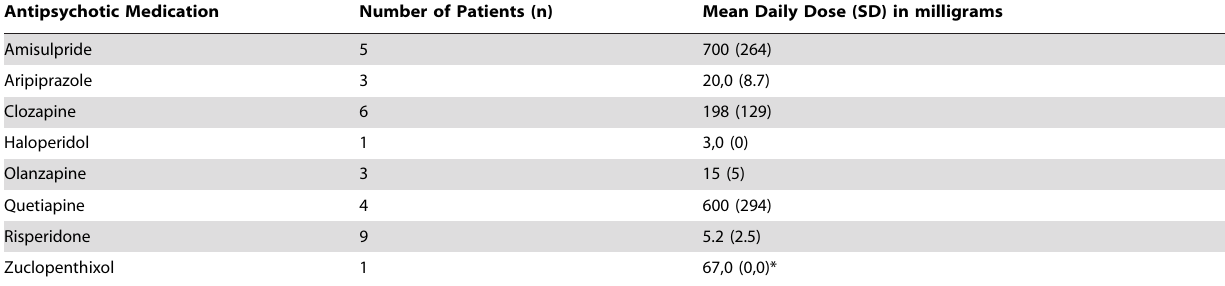
Table 1. Antipsychotic medications.